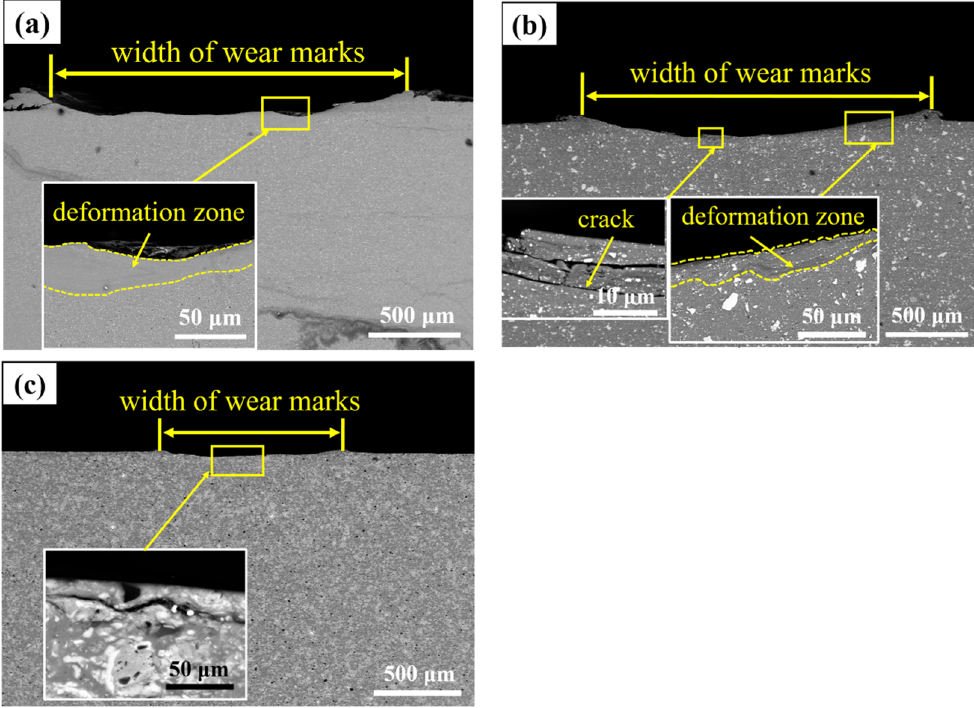
Figure 11. SEM micrograph of the clip plane of sample worn surface after wear test at 200 °C. ( a ) Al 7075; ( b ) 15 wt.% VN/7075; ( c ) 20 wt.% TiB 2 -TiC x /7075.